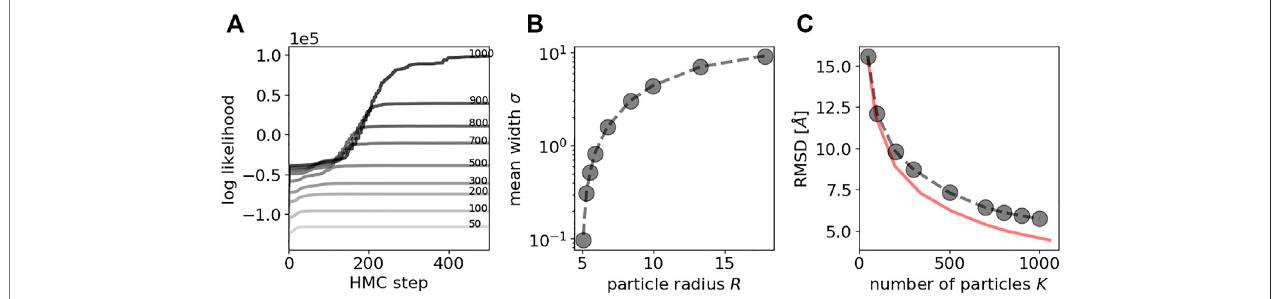
FIGURE2| HMCsamplingofparticlepositionswith fi xedrotationsforasimulateddatasetofGroEL/ES.AEvolutionoftheloglikelihoodduringHMCsampling.The largerthenumberofparticles K ,thehigheristhe fi nalloglikelihood.Increasingdarknessindicateslargernumberofparticles.Lineannotationsalsoindicatethenumberof particles. B Average standard deviation (computed over all 35 input point clouds) vs. the size of the particle R . C RMSD between Carbon-alpha positions of the crystal structureandthecoarse-grainedmodelsinferredwithHMC.Asareference,theRMSDbetweentheCarbon-alphapositionsandthecoarse-grainedversionsofthe crystal structures is shown as red